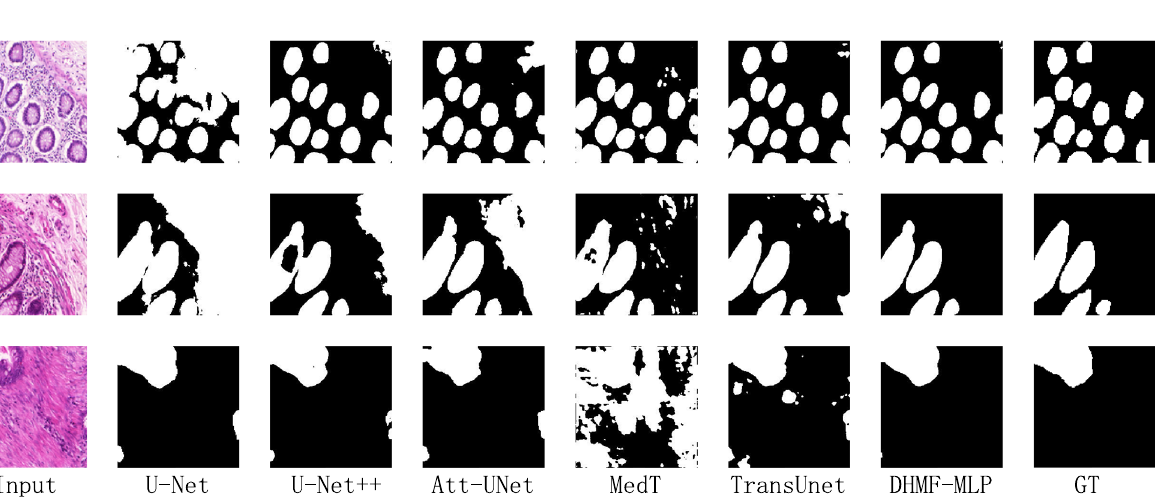
Figure 7. Qualitative comparison results for the GlaS dataset. From left to right: input, U-Net 14 , U-Net++ 16 ,